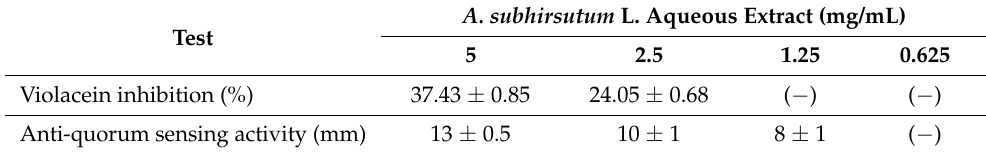
Table 4. Violacein inhibition anti-quorum sensing activities of A. subhirsutum aqueous extract. ( − ): No activity.